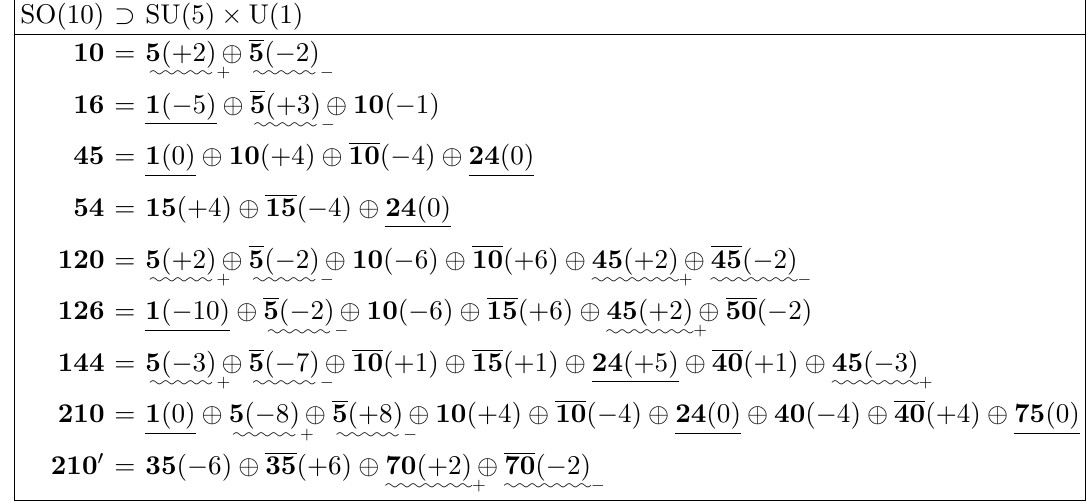
Table 10 . Decomposition of the lowest dimensional irreducible representations of SO(10) under the maximal subgroup G 51 . The U(1) charges need to be multiplied with an additional factor (2 for proper normalization corresponding to a Dynkin index 2. Terms with a straight underline contain one SM singlet, while terms with a wavy underline contain one weak doublet, with an additional label + or (cid:0) identifying the representation as ( 1 ; 2 ; (cid:6) 1